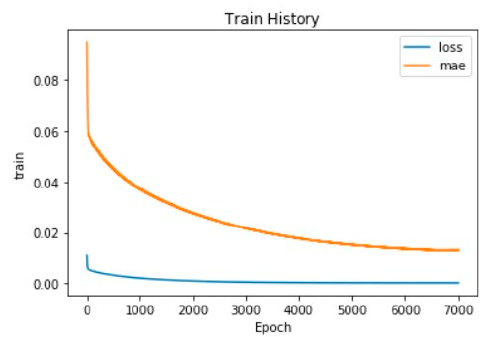
Figure 17. 05-Jan-2014 The training process of RNN.